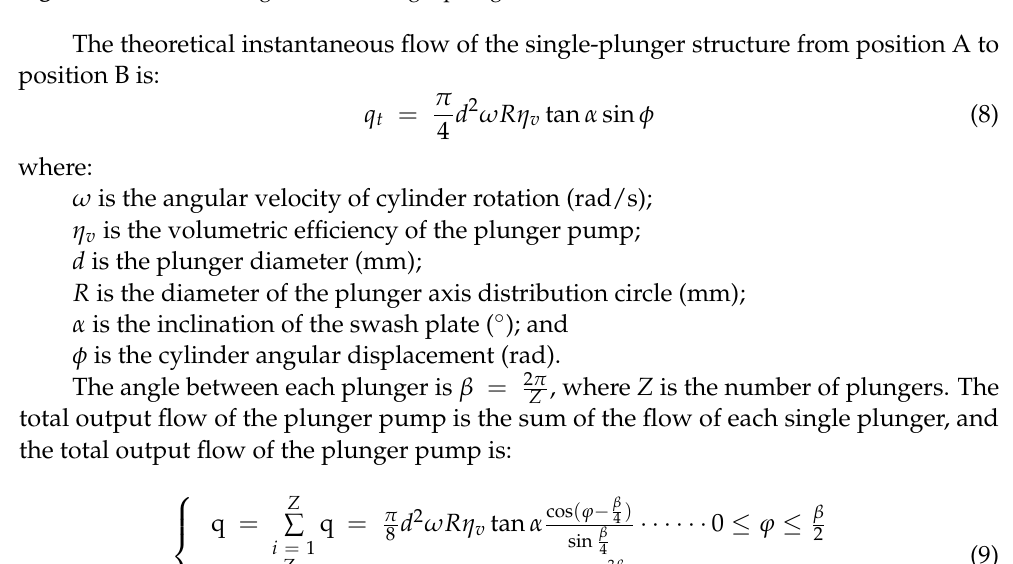
Figure 2. Movement diagram of the single plunger structure.